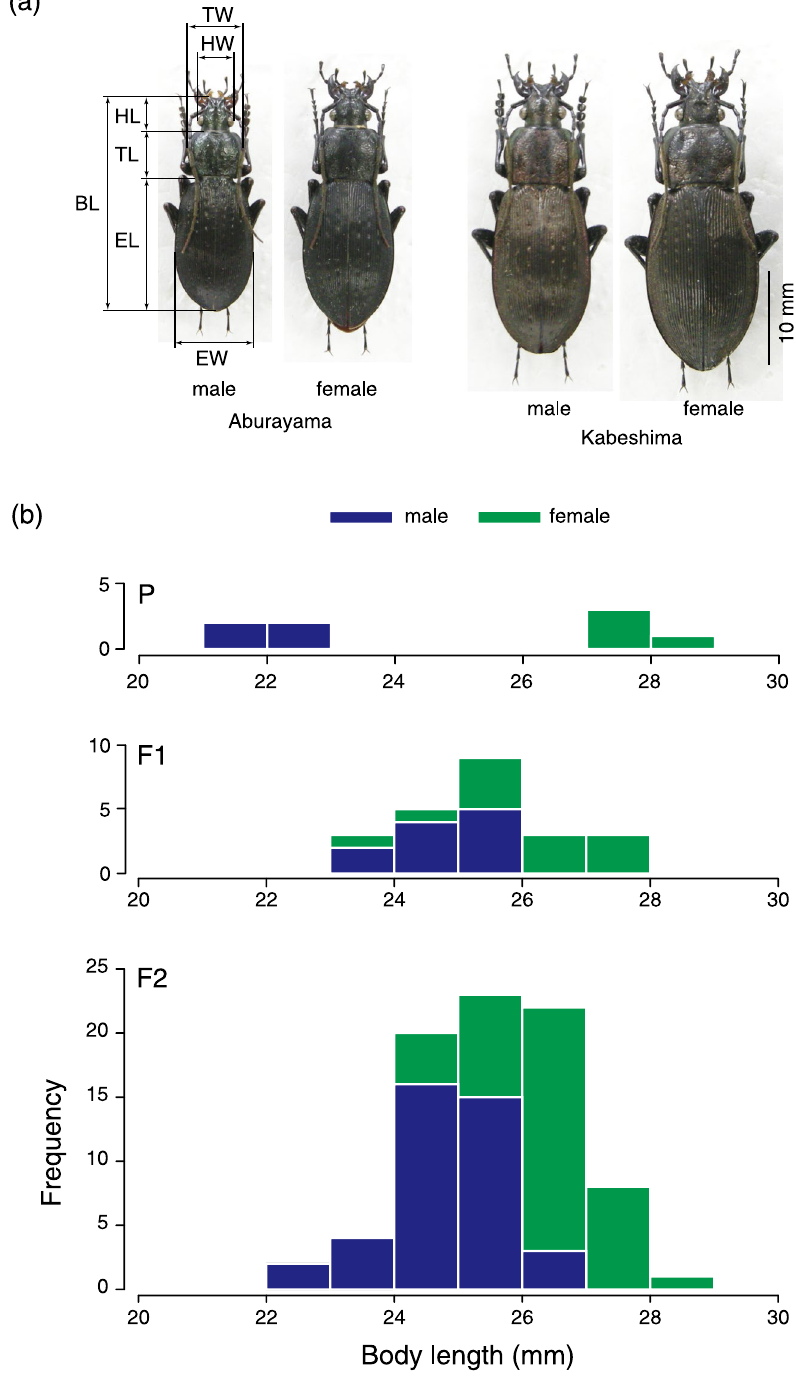
Figure 1. The body lengths of adult P, F 1 , and F 2 Carabus japonicus beetles. ( a ) Males and females from Mt. Aburayama and Kabeshima Island were used in the present study. Measurements of body dimensions are shown. BL, body length; HW, head width; HL, head length; TW, thoracic width; TL, thoracic length; EW, elytral width; EL, elytral length. ( b ) BLs of parents and F 1 and F 2 individuals in the crossing